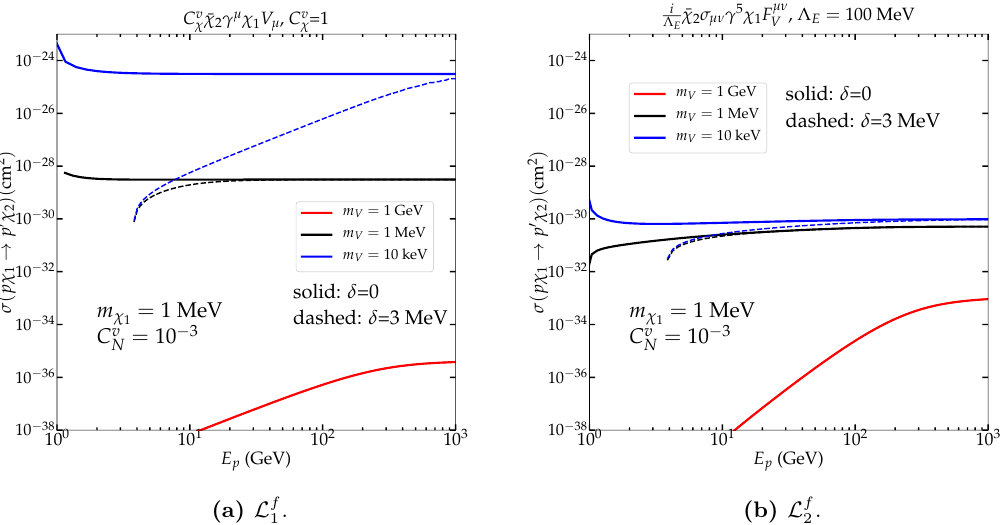
Figure 3. The integrated cross section for the process pχ 1 → p 0 χ 2 with respect to the energy of incoming proton E for L f (left panel) and L f (right panel). Three mediator masses 10 keV (blue p 1 2 lines), 1 MeV (black lines), and 1 GeV (red lines) are shown. The difference between the red dashed line and red solid line are negligible. We only plot the SM vector interaction ( C a